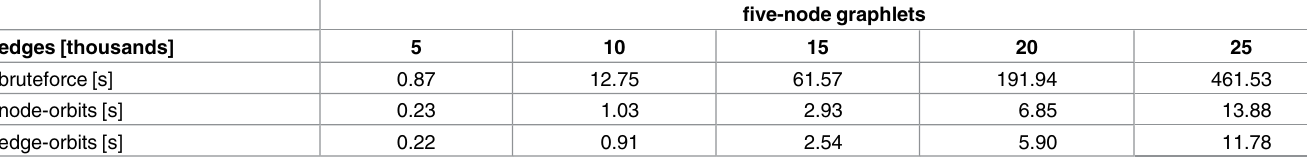
Table 3. Comparison of run times for counting node- and edge-orbits of 5-node